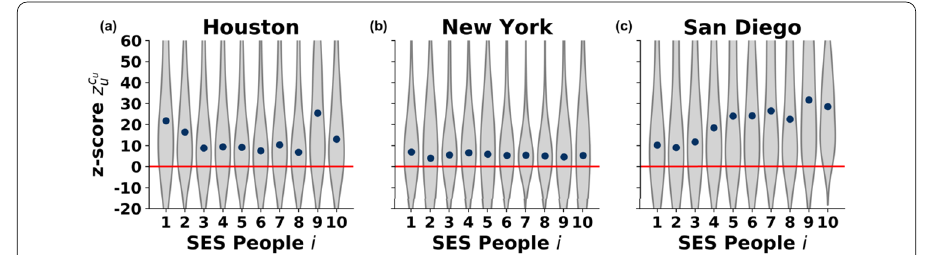
Figure 4 Class-level Bias z-score z cu u . Distribution of class-level biased z-scores as the function of socioeconomic classes. Distributions are shown for each socioeconomic class with their median values as blue points for Houston (Fig. 4( a )), New York (Fig. 4( b )), and San Diego (Fig. 4( c )). Z-score values corresponding to unbiased cases are shown with red solid lines. Positive z-score values signal an upward visiting